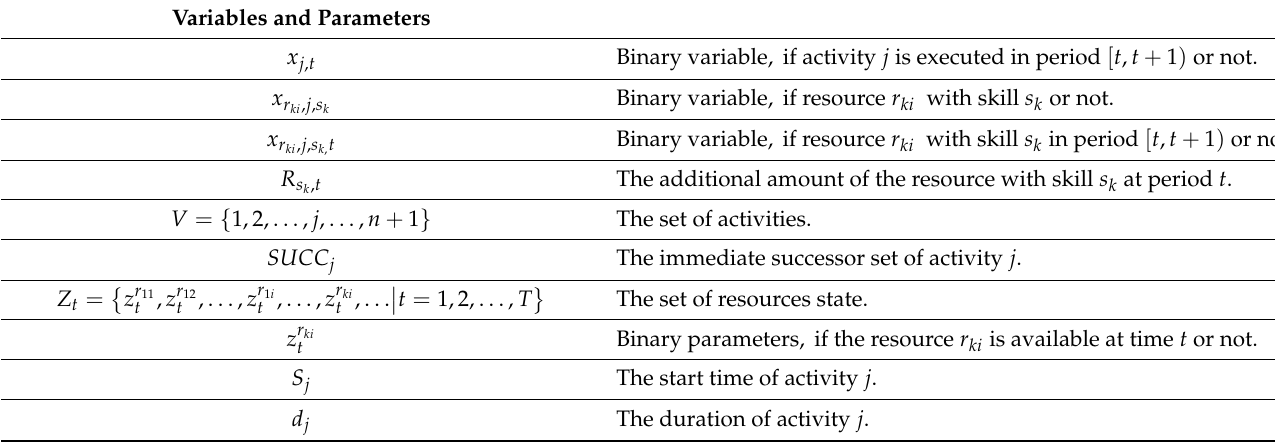
Table 1. Variables and